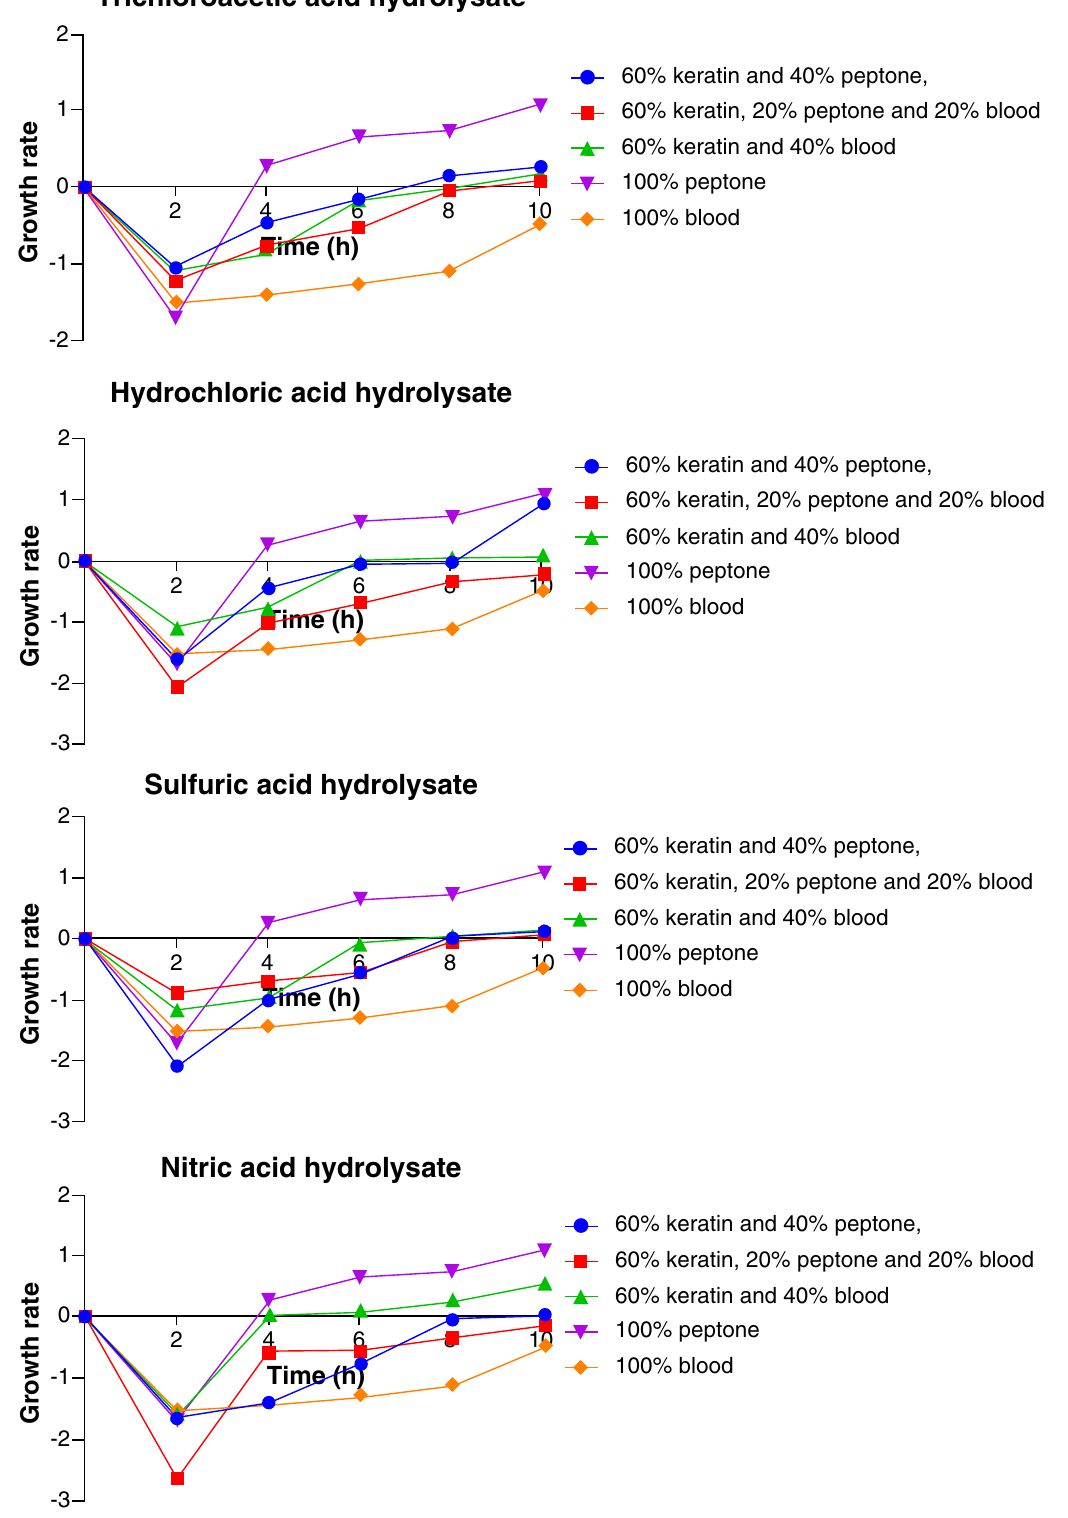
SO and HNO 2 4 3